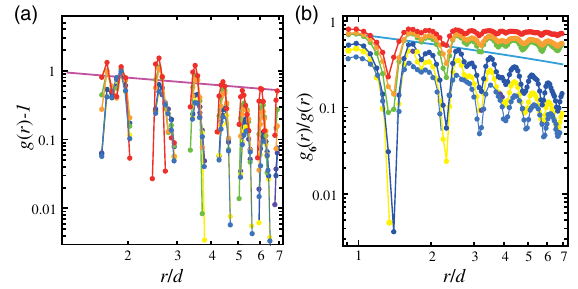
FIG. 2. ϕ dependence of g ð r Þ and g 6 ð r Þ =g ð r Þ for a steel ball system for Γ ¼ 3 . 3 . To visually confirm a decay slower than the asymptotic decay for ordered phases, we plot the data in the log- log plots, where only the points having positive values are displayed. (a) ϕ dependence of g ð r Þ . The symbols are ϕ ¼ 0 . 70 (dark blue), 0.71 (yellow), 0.72 (green), 0.73 (orange), and 0.74 (red) from the bottom to the top. The straight line has a slope of − 1 = 3 . (b) ϕ dependence of g 6 ð r Þ =g ð r Þ . The symbols are ϕ ¼ 0 . 65 (bright blue), 0.70 (dark blue), 0.71 (yellow), 0.72 (green), 0.73 (orange), and 0.74 (red) from the bottom to the top. The straight line has a slope of − 1 = 4 . From these results, we identify ϕ ¼ 0 . 65 , 0.70, and 0.71 as a liquid state, ϕ ¼ 0 . 72 and 0.73 as a hexatic state, and ϕ ¼ 0 . 74 as a solid